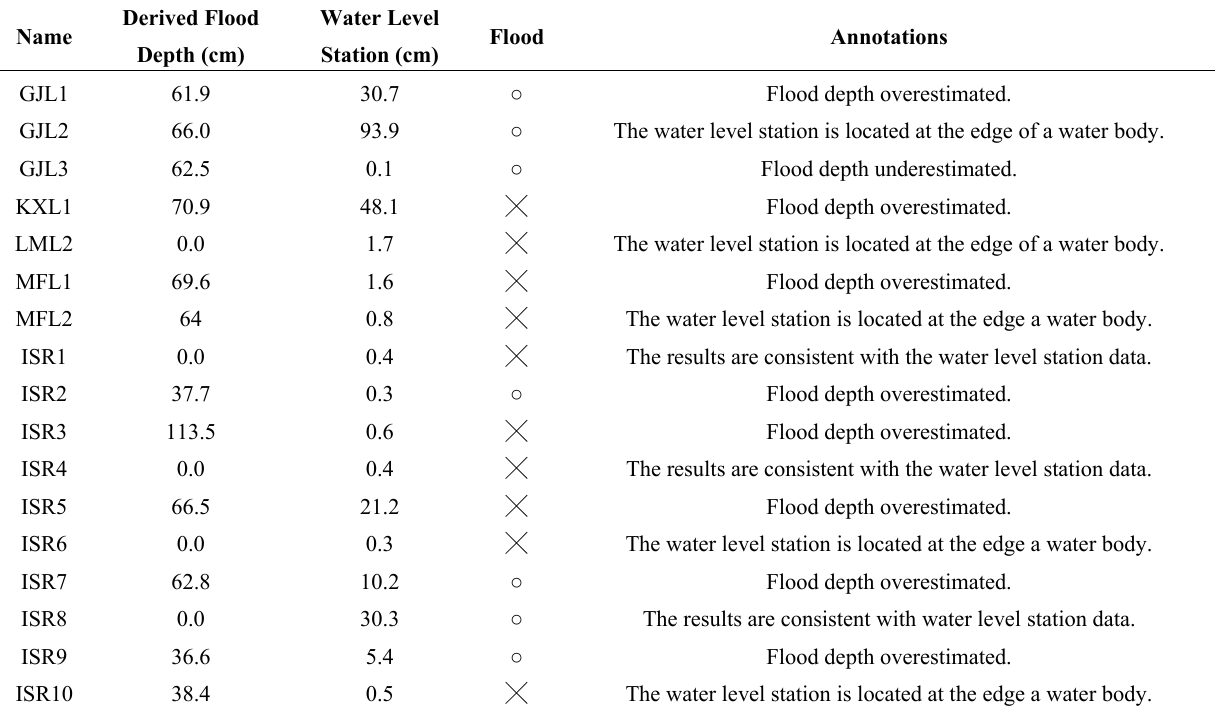
Table 3. Comparison between the flood extent map and different inundation potential